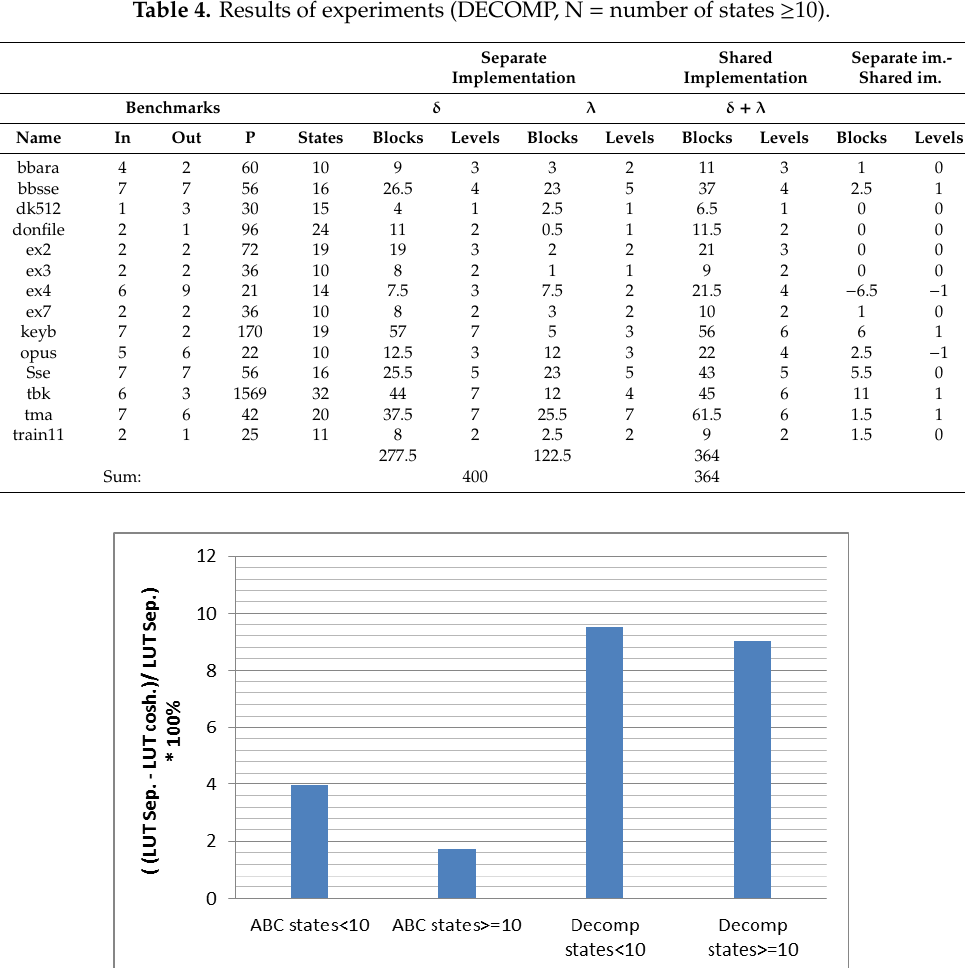
Figure 14. Limitation of the number of LUT blocks.